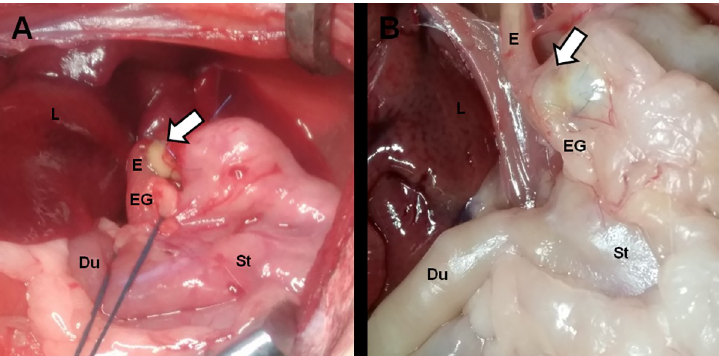
Fig 4. Transplantation of the structures. A. The surgical site of transplantation. B. The transplanted site at 30 days after transplantation. Arrows: transplanted site, Du: duodenum, E: esophagus, EG: esophagogastric junction, L: liver, St: